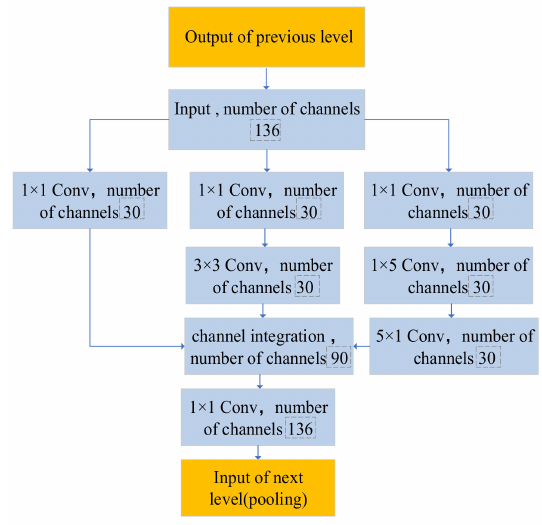
Figure 7. Inception 1 structure.